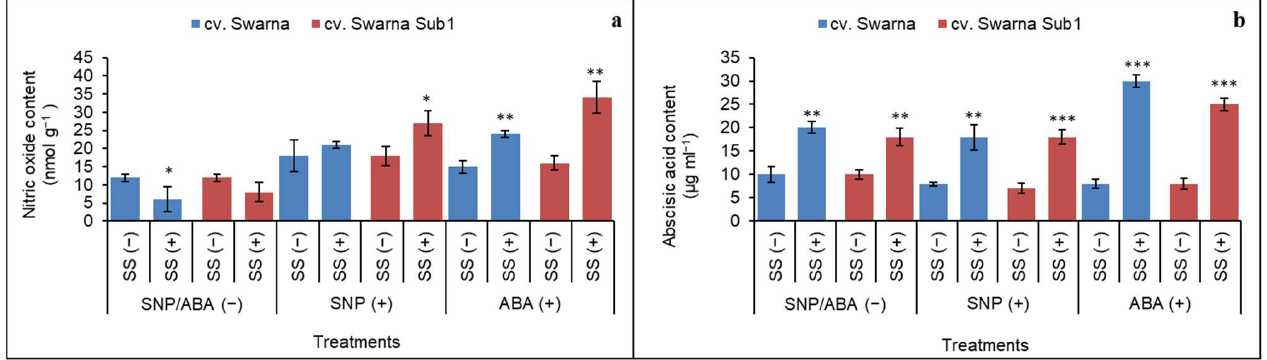
Figure 1. Changes in nitric oxide ( a ) and abscisic acid ( b ) contents in two rice genotypes (cv. Swarna and Swarna Sub1) under salinity stress [SS (+)] and non-salinity stress [SS ( − )] for 72 h with [SNP (+) or ABA (+)] or without [SNP/ABA ( − )] priming for 24 h. Data are presented in bars with mean ± SE ( n = 3) from independent experimental sets and the significant values are represented as * ( p ≤ 0.05), ** ( p ≤ 0.01) and *** ( p ≤ 0.001) by student’s t -test to denote the significant difference between SS ( − ) and SS (+) of SNP/ABA ( − ) as well as SNP (+) and ABA (+) of each rice